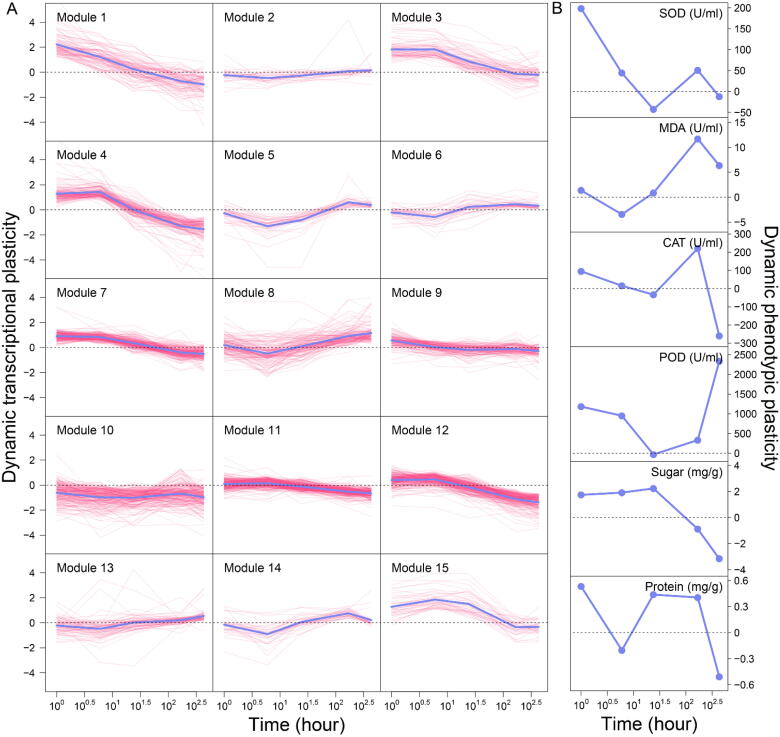
Dynamic transcriptional plasticity (DTP) of 15 distinct modules among 1,819 salt-responsive genes (A) and dynamic phenotypic plasticity (DPP) of six salt resistance-related physiological traits (B) measured from roots of Euphrates poplar clones grown under salt-free and salt-stress conditions. Purple thin lines are the DTP curves of individual genes within a module, and thick blue lines represent the mean curves of all genes from this module. (For interpretation of the references to colour in this figure legend, the reader is referred to the web version of this article.)